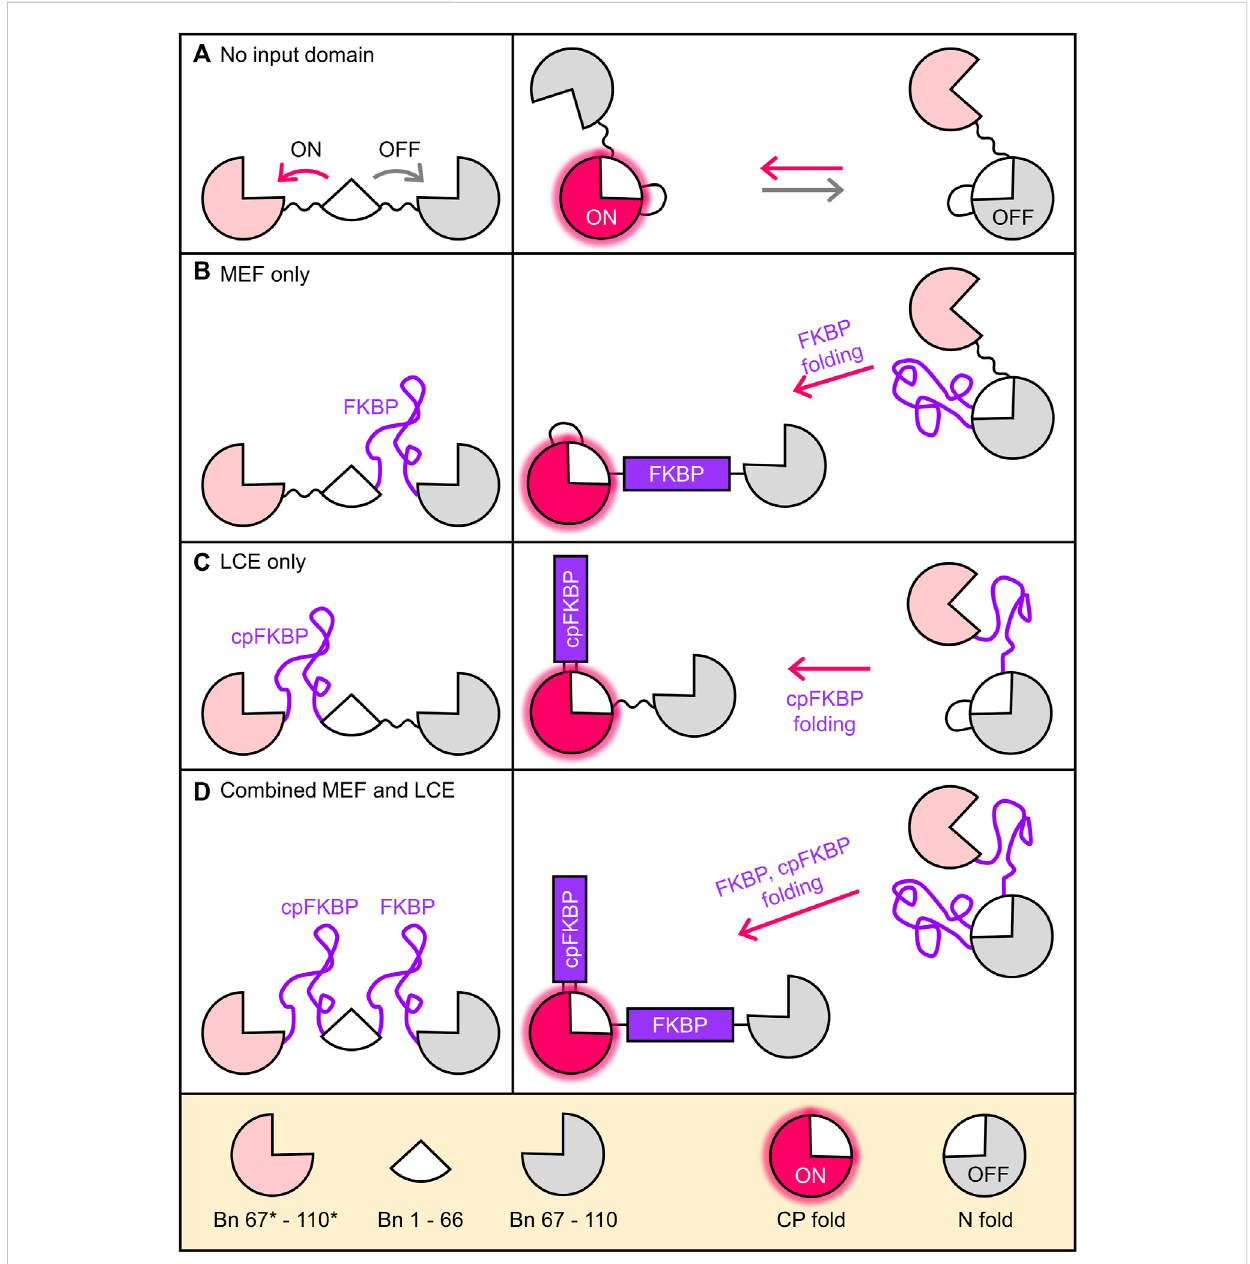
FIGURE 1 Coupling folding of FKBP receptor domains to the Bn-AFF fold shift. (A) By duplicating a portion of the Bn sequence, Bn-AFF switches between the N-fold(OFFstate)andtheCP-fold(ONstate).Mutualexclusivityoffoldingisestablishedbycompetitionofthetwoduplicatesegments(pinkandgrey)for thesamesharedsegment(white).WithoutanFKBPreceptordomainthisoccursinaspontaneous,unregulatedfashion. (B) TosimulateMEFswitching,an unstableFKBPdomainwasinsertedintotheN-frameatthesurfaceloopseparatingthesharedandduplicateregions.FoldingofFKBPsplitsapartthe N-fold and the switch shifts to the CP-fold. (C) LCE switching was simulated by placing an unstable cpFKBP domain between the duplicate and shared regionsoftheCP-fold.cpFKBPfoldingremovestheentropicpenaltytofoldingoftheCP-foldanddrivestheN-to-CPconformationalchange. (D) Thefull MEF-LCEswitch wasconstructedbyinsertingbothFKBP andcpFKBPatthepointsdescribedabove.Foldingofthesedomainsprovidesmaximumdriving force for Bn-AFF